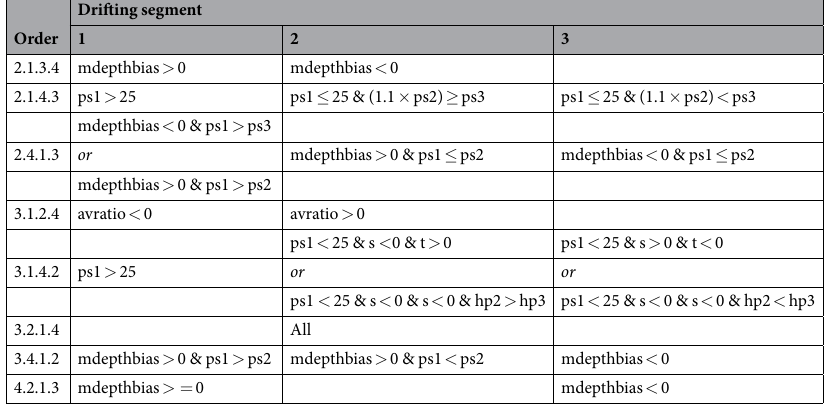
Table 2. Eight main RBSA groups identified by the inflection point ordering which comprised the majority (90.5%) of drift dives. The criteria shown are those used to determine the drifting segment of the candidate drift dives within groups. All dives of the 3.2.1.4 group have the same drifting segment (segment 2) so no criteria is required to determine it. {f, s, t} are the change of depth with respect to time for the first, second, and third segments (excludes the initial/descendant, and last/ascent